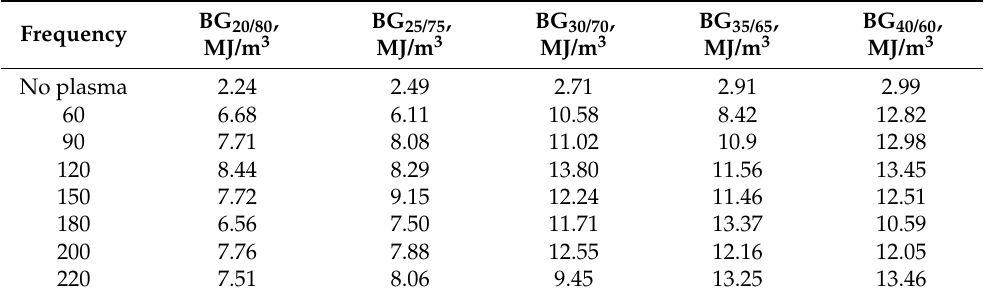
Table 2. Calorific value of proceeded gases of different biogas variants.